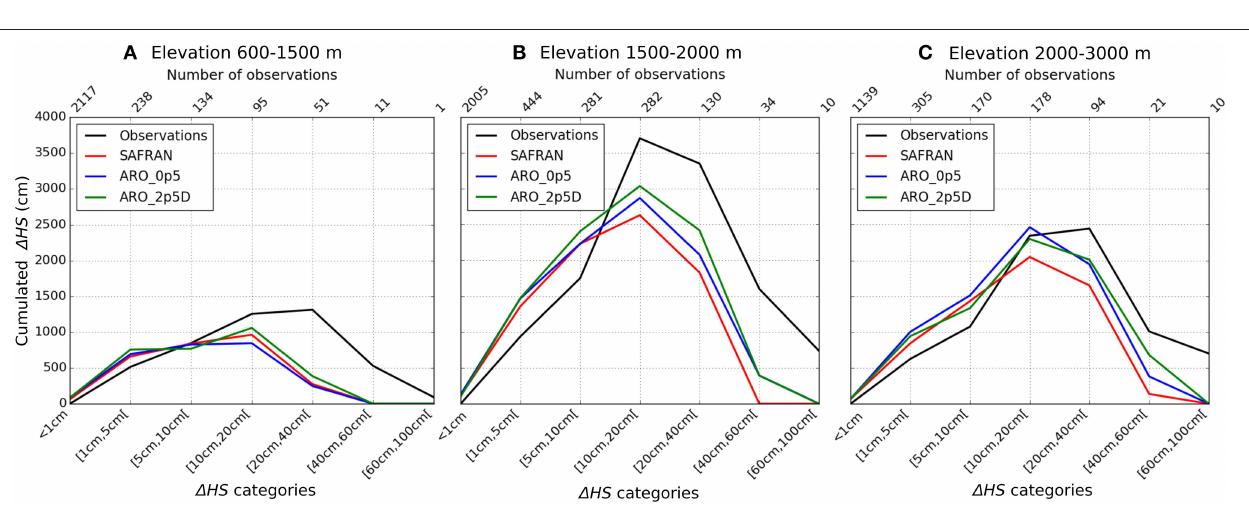
FIGURE 6 | Cumulated daily snow depth variations, 1 HS , by categories in the observation dataset and the different snowpack simulations for several elevation bands: (A) 600–1,500 m, (B) 1,500–2,000 m, and (C) 2,000–3,000 m. The upper x axis shows the number of observations per